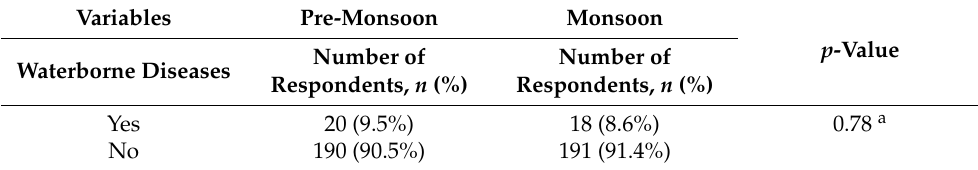
Table 2. Proportion of households with waterborne diseases.